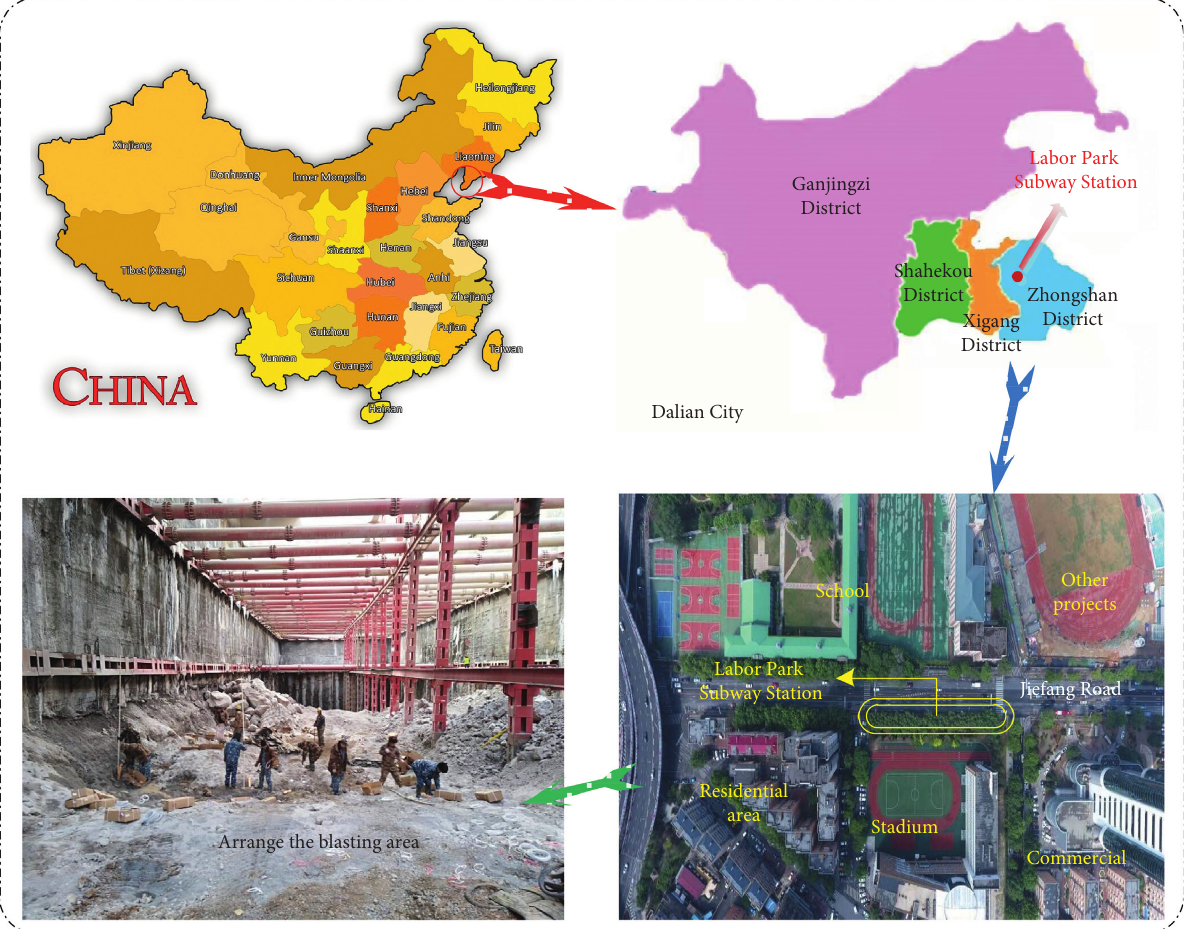
Figure 2: Sketch map of project